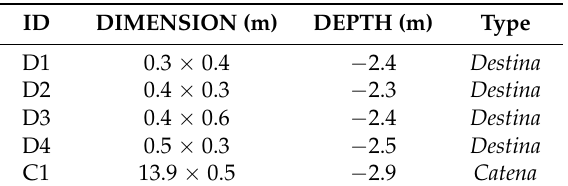
Table 3. Table of the planar dimensions of the wooden board traces on the top face of the pila .